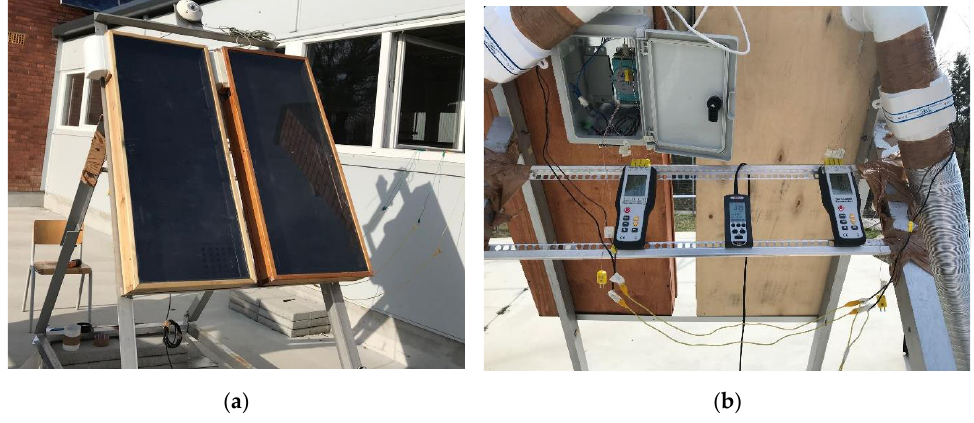
Figure 2. The experimental set-up of the unit (( a ) front side, ( b ) rear side). Table 1. Geometrical dimension of the two-pass solar air collectors.